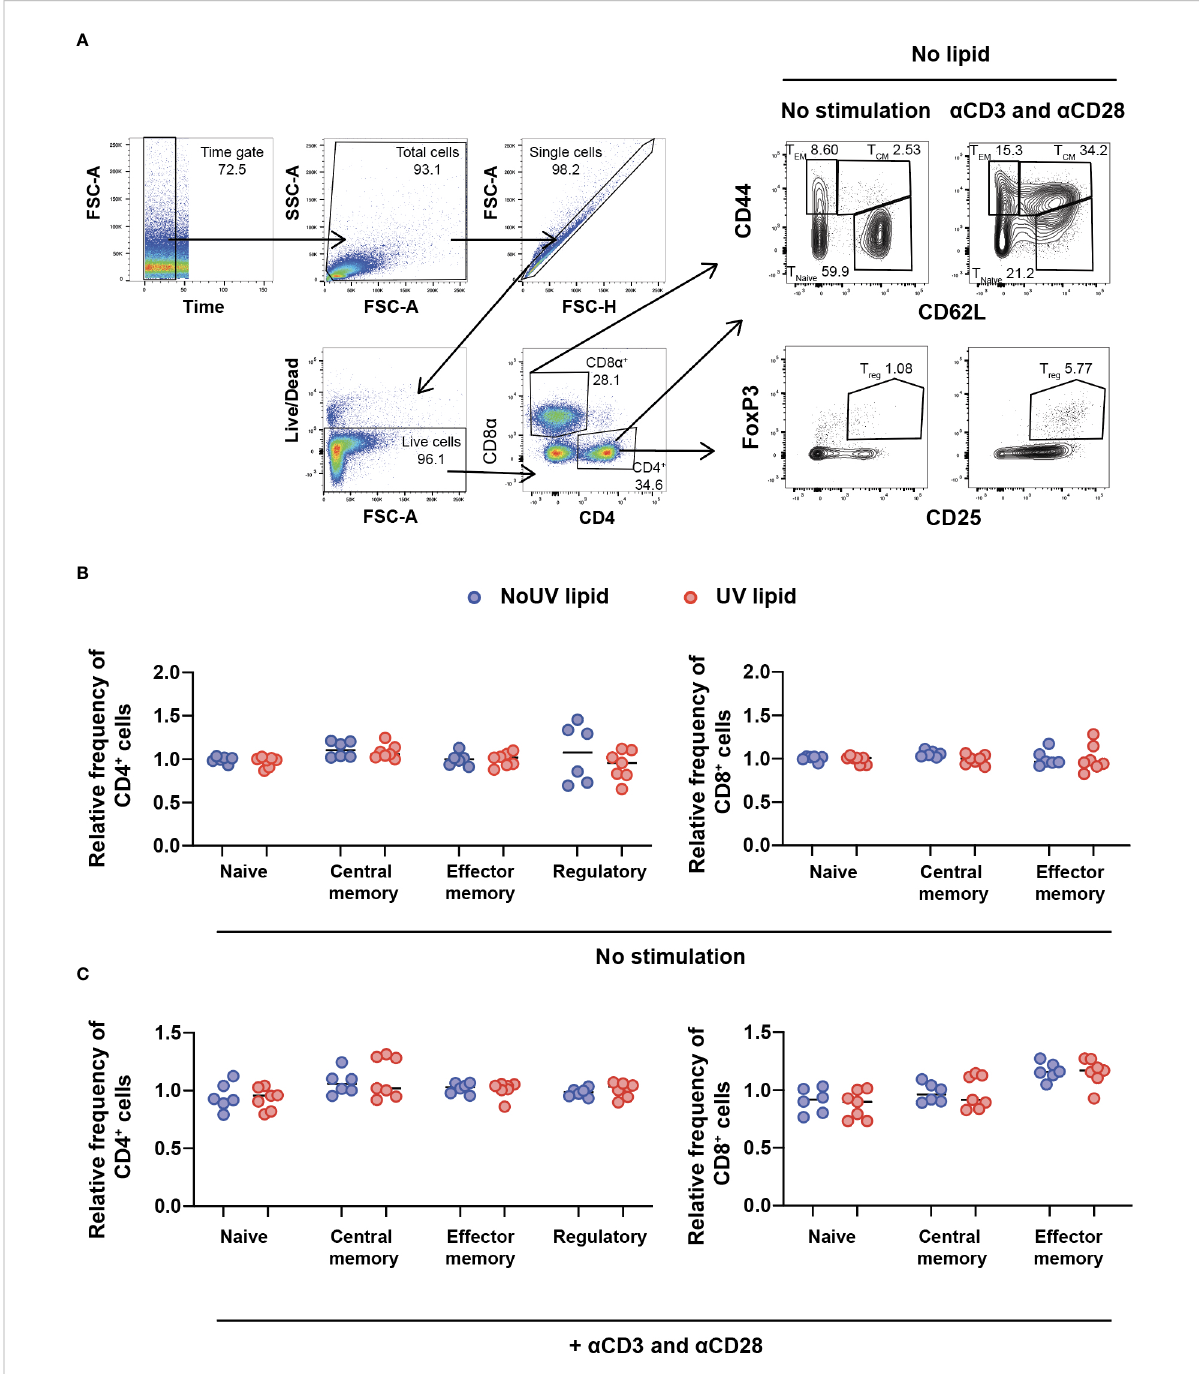
FIGURE 3 Lipids derived from UV-irradiated skin-draining lymph nodes have no effect on T cell subsets. Skin-draining lymph nodes were collected and lipids extracted. Lipids were then added to untreated skin-draining lymph node cells with or without anti-CD3 and anti-CD28 stimulation. Cells were cultured for 24 hours and stained for fl ow cytometry analysis. (A) Gating strategy for the identi fi cation of CD4 + and CD8 + T cell subsets. CD62L hi CD44 lo T cells were de fi ned as naïve, CD62L hi CD44 hi T cells as central memory, CD62L lo CD44 hi T cells as effector memory and CD4 + CD25 + FoxP3 + cells as regulatory T cells. (B) T cell subsets following lipid co-culture without stimulation. (C) T cell subsets following lipid co-culture with stimulation. Relative frequency was calculated as a ratio to the no lipid control of each independent experiment. Median and individual mice (lipid donors, n = 6-7) from 2 independent UV-irradiation experiments are shown. Statistics were done by two-tailed unpaired Mann-Whitney